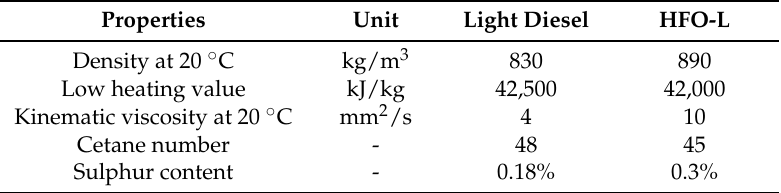
Table 3. Properties of HFO-L. HFO: heavy fuel oil; and HFO-L: HFO and light diesel